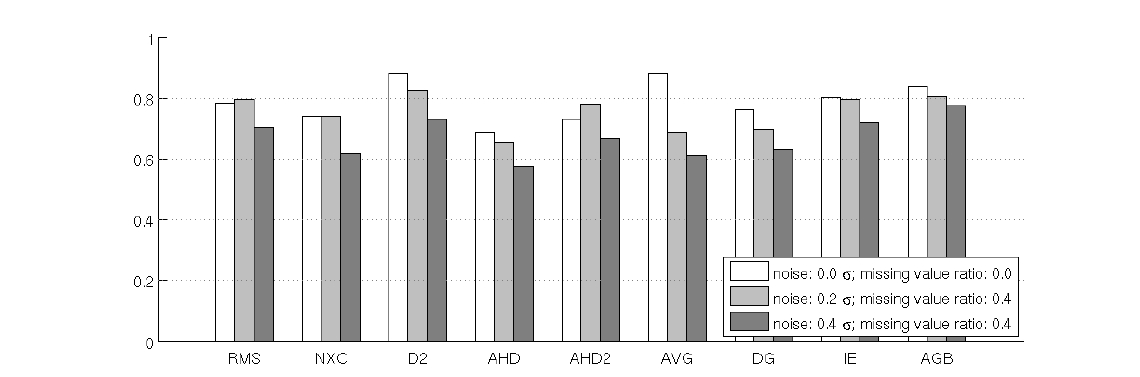
Figure 12. Results of the time-series test. Bar height indicates average fraction of passed tests for the 6 time series of